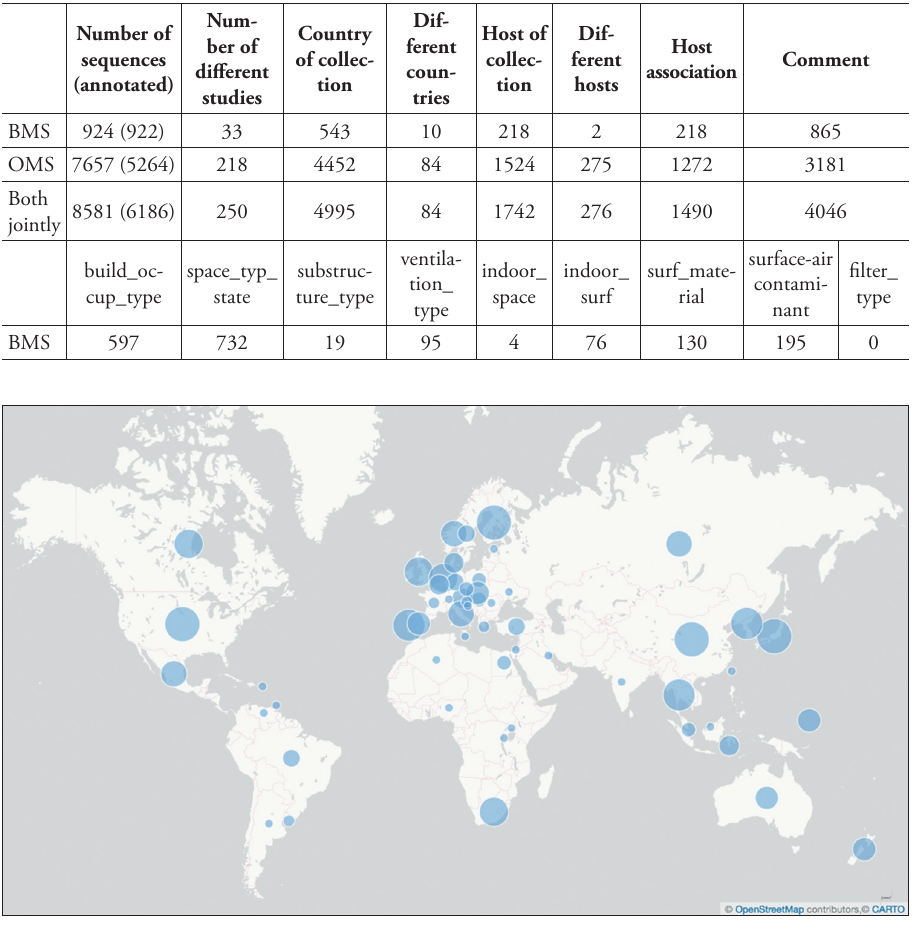
Figure 1. Analysis of the built environment sequences for country of collection. Country centroids based on the geographical centres of contiguous country land masses are marked with bubbles of different size on the global map to indicate the number of built environment sequences originating from these countries as stated explicitly in the underlying INSDC records or as restored during the present effort and in Ab- arenkov et al. (2016) (57 distinct countries, sequence count ranging from 1 to 3,091). The figure is based on Abarenkov et al. (2016) plus the data added during the workshop, such that it indicates the scientific state of ITS-based Sanger-derived sequencing of the built mycobiome as of spring